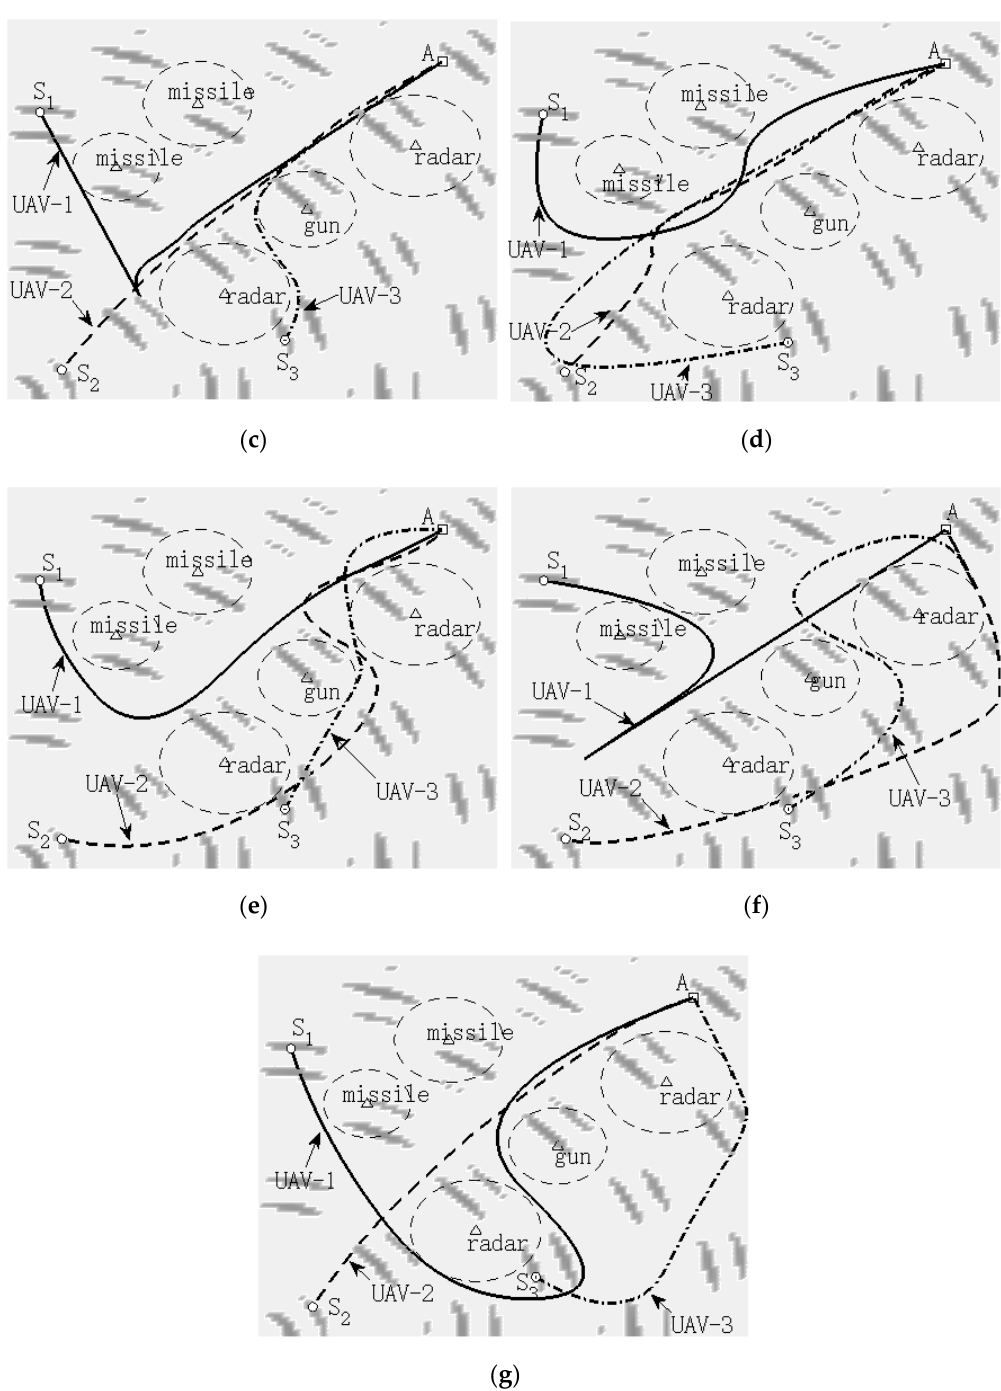
Figure 4. Two-dimensional displays of the best UAV paths obtained by ( a ) MSFOA, ( b ) FOA, ( c ) PSO, ( d ) DE, ( e ) ABC, ( f ) IFFO, and ( g ) MFOA in the third scenario.